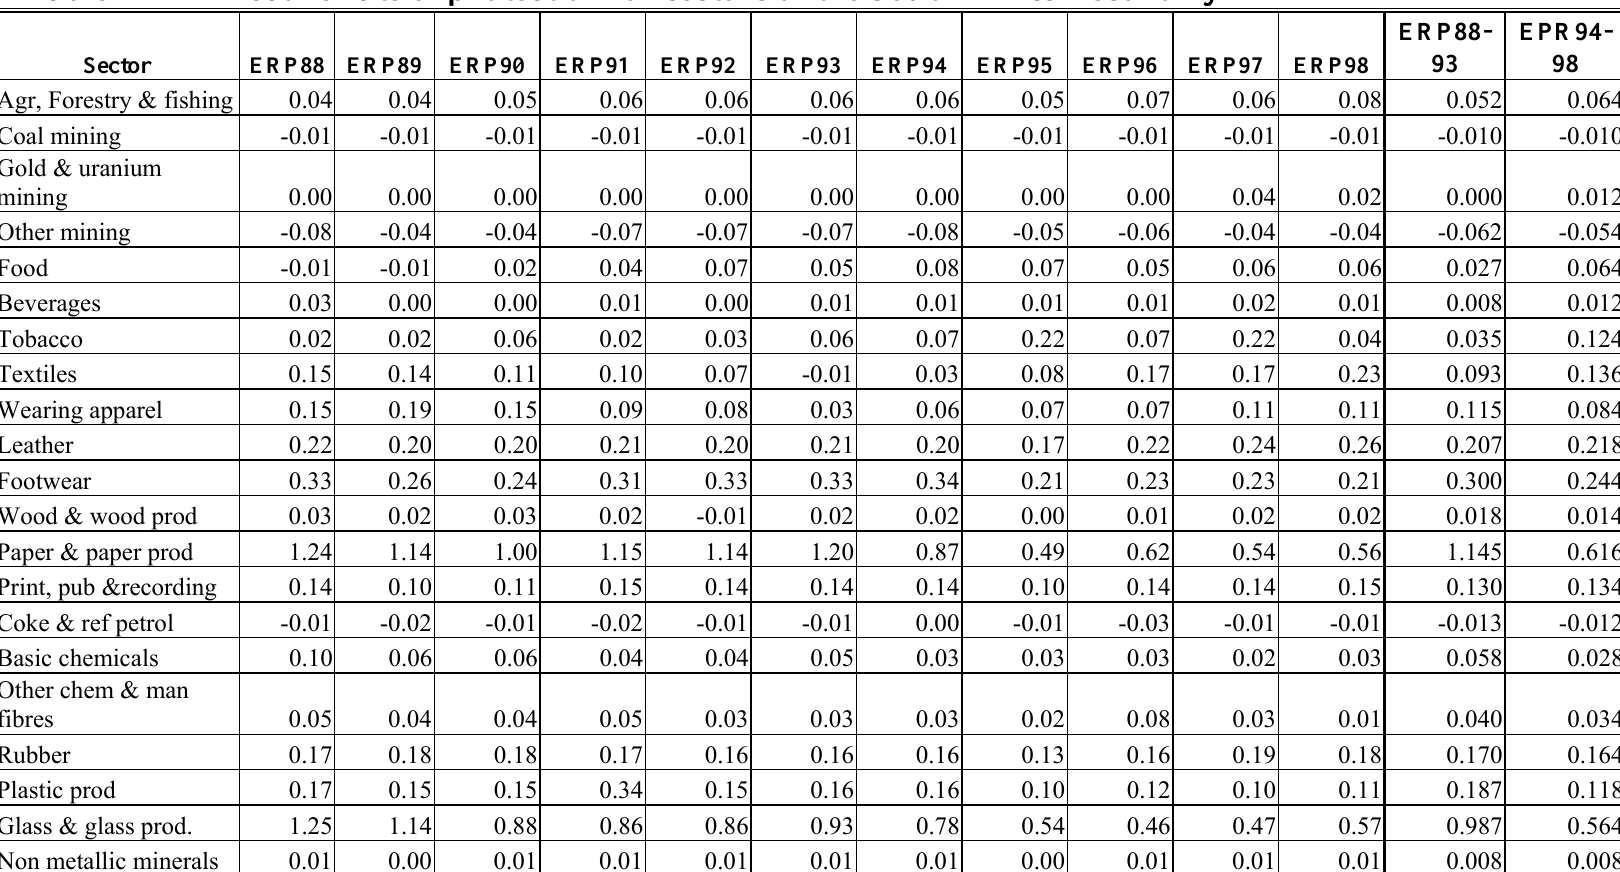
Effective rate of protection for sectors of the South African